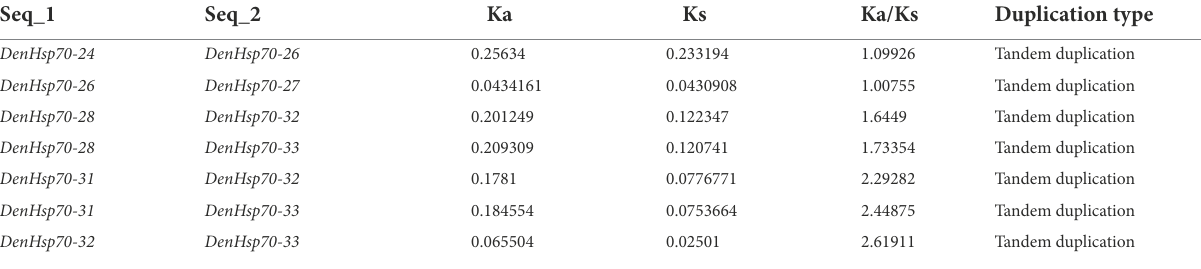
Synonymous (Ks) and non-synonymous (Ka) substitution rates of duplicate gene pairs (Ka/Ks